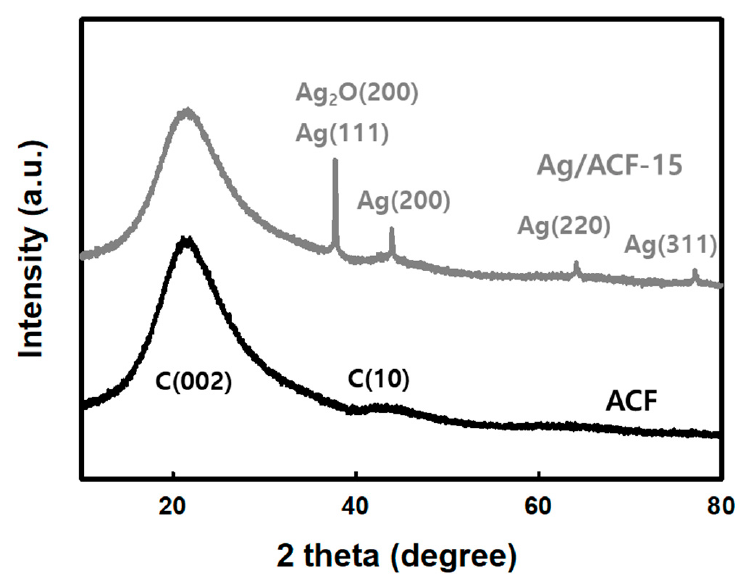
Figure 4. X-ray diffraction patterns of ACF and Ag/ACF-15 composite. Figure 5 shows the C1s, O1s, Ag3d, and Ag MNN XPS spectrum of the Ag/ACF-15 composite. In Figure 5a, C1s photoelectron line was fitted to three contributions. The peak at binding energy (BE) 284.6 eV was due to the graphite carbon C-C bond, the peak at BE 286.2 eV was due to the C-O bond, and the peak at BE 287.1 eV was due to the carbon of the C=O bond [22,23]. In the O1s region of Figure 5b, three fitted photoelectron lines were observed, and the weak binding energy peak of 529.8 eV was due to a Ag-O bond. The results in Figure 4 confirmed that the Ag precipitated on the ACF surface was in the form of metallic Ag and Ag 2 O crystals. Therefore, the peak is due to the Ag-O bond of Ag 2 O [24]. The peaks at 531.2 eV and 532.2 eV were assigned to oxygen bonded to the carbon of ACF-15 composite, such as C=O and C-OH or C-O-C bonds [25]. Figure 5c is the XPS result for the Ag3d region, and two doublet-fitted photoelectron lines were observed. The peaks observed at BE 367.6 eV and 373.6 eV were generated by Ag 2 O with an oxidation state of +1, and the peaks generated at BE 368.3 eV and 374.3 eV were peaks by metallic silver (Ag 0 ) [26–28]. In addition, the spin orbital splitting between Ag 3 d 5/2 and Ag 3 d 3/2 of Ag 2 O and metallic silver was maintained at 6.0 eV [28]. Figure 5d is a Ag MNN spectrum, and a weak intensity peak was observed. Kinetic energy (KE) peaks at 350.2 eV and 352.2 eV are peaks by Ag M 5 N 45 N 45 of Ag +1 and Ag 0 . Auger parameter (AP) was calculated using BE of Ag3d 5/2 and KE of Ag MNN (Ag M 5 N 45 N 45 and Ag M 4 N 45 N 45 ), and AP of Metallic Ag was 720.5 eV (Ag3d 5/2 -Ag M 5 N 45 N 45 ) and 726.4 eV (Ag3d 5/2 -Ag M 4 N 45 N 45 ). The AP of Ag +1 was calculated to be 717.8 eV (Ag 3d 5/2 -Ag M 5 N 45 N 45 ) and 723.7 eV (Ag3d 5/2 -Ag M 4 N 45 N 45 ), and it was confirmed that it was due to silver ion of Ag 2 O [28]. Overall, XPS showed that the Ag particles precipitated by LPP were a mixture of metallic silver and silver oxide, which is consistent with the XRD pattern in Figure